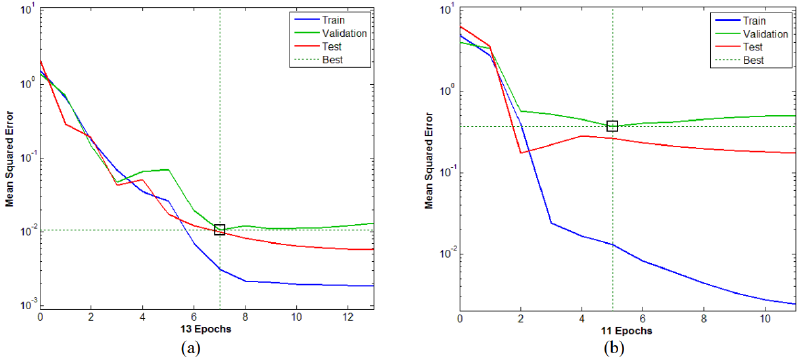
Figure 3. ( a ) Training performance of ANN model for flat surface; ( b ) Training performance of ANN model for cylindrical surface.